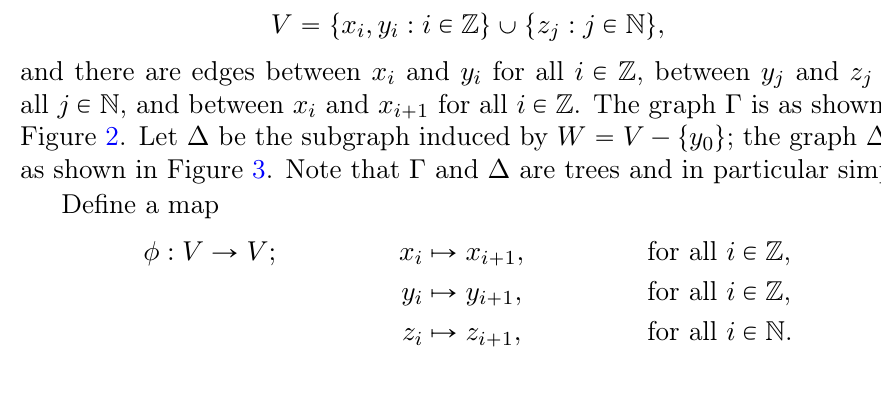
; the graph ∆ is 0 u